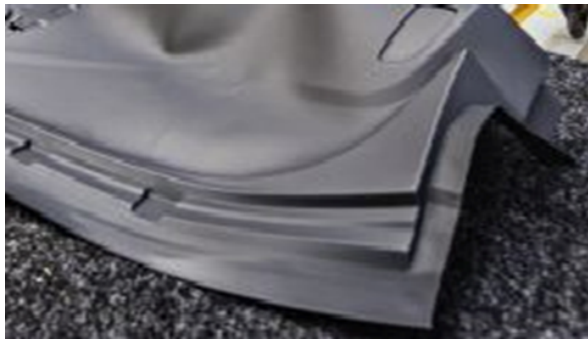
Figure 1: A section of the top part of dashboard made of PVC powder. Source: